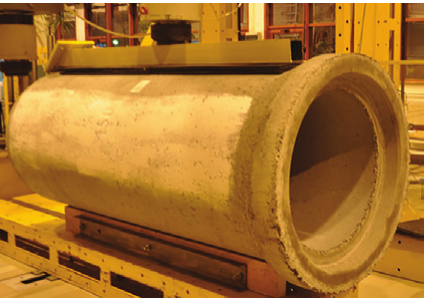
Fig. 6. The setup of static testing